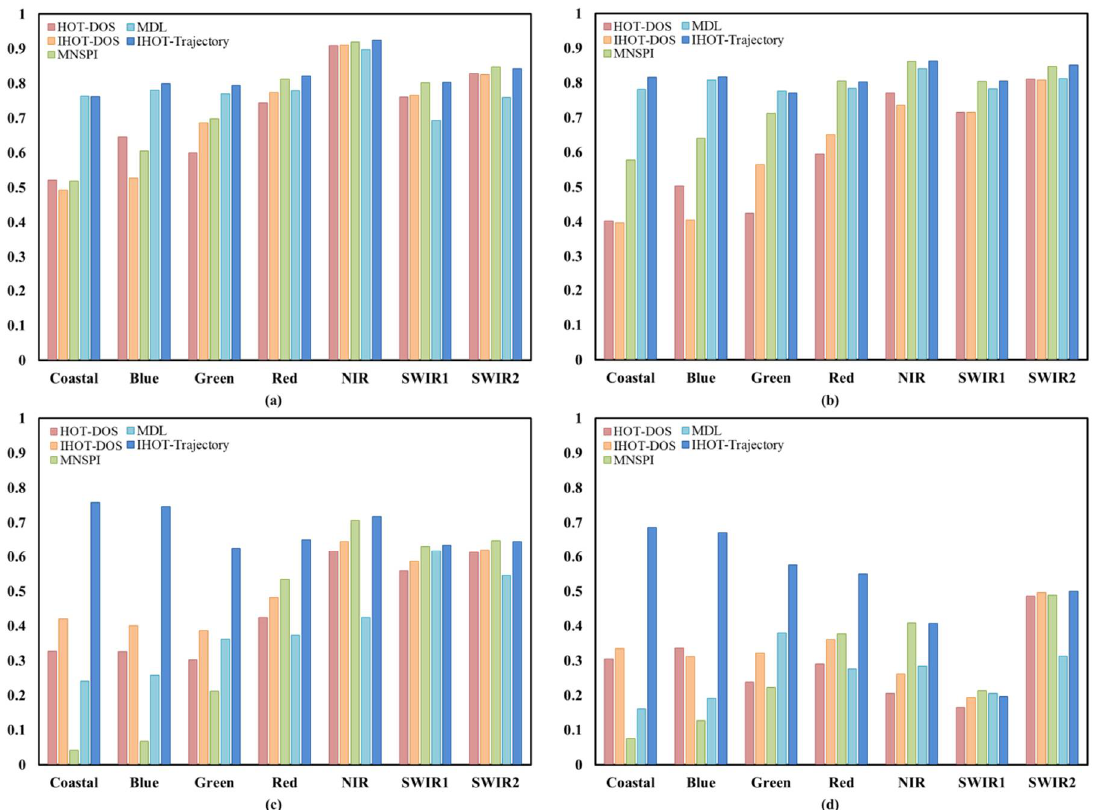
Figure 7. Correlation coefficients ( r ) between the reference image and the restored image using haze optimized transformation-dark object subtraction (HOT-DOS), iterative haze-optimized transformation-DOS (IHOT-DOS), IHOT removal of cloud trajectory (IHOT-Trajectory), modified neighborhood similar pixel interpolator (MNSPI) and multitemporal dictionary learning (MDL). ( a – d ) correspond to r of Figures 5b,c and 6b,c, respectively.